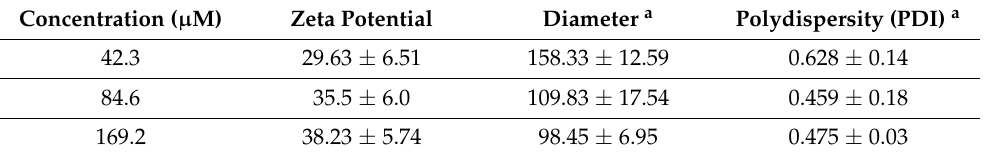
Table 1. Zeta potential and mean diameter values of